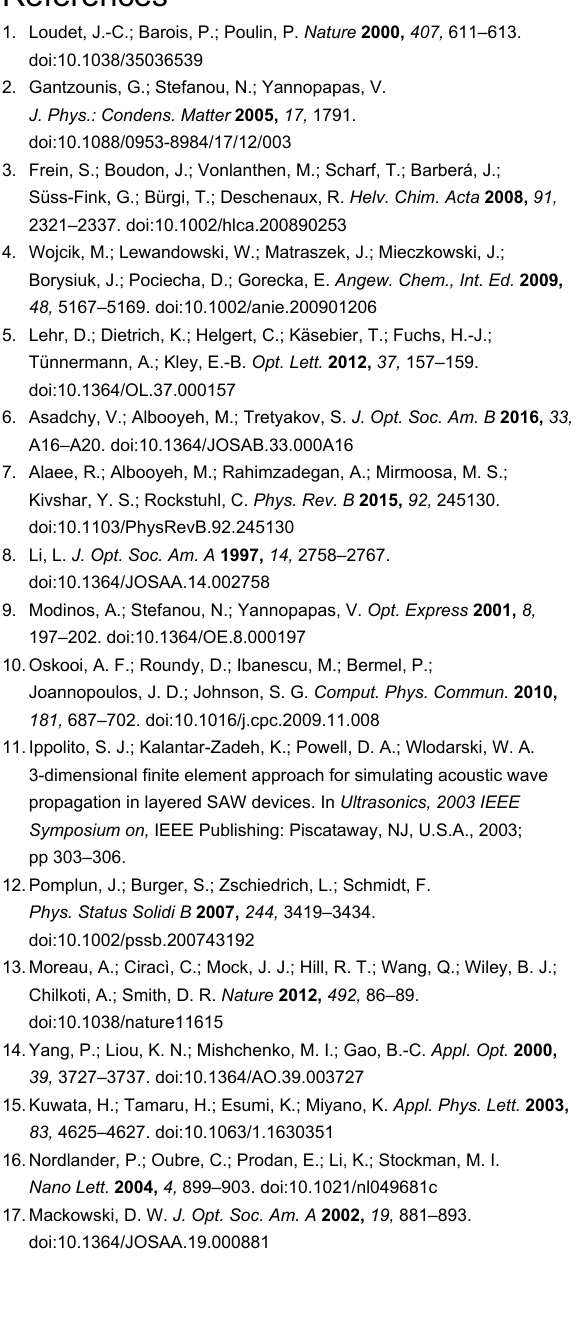
Figure 12: Duality breaking, electromagnetic chirality and cross section contrast of the left-handed helix.